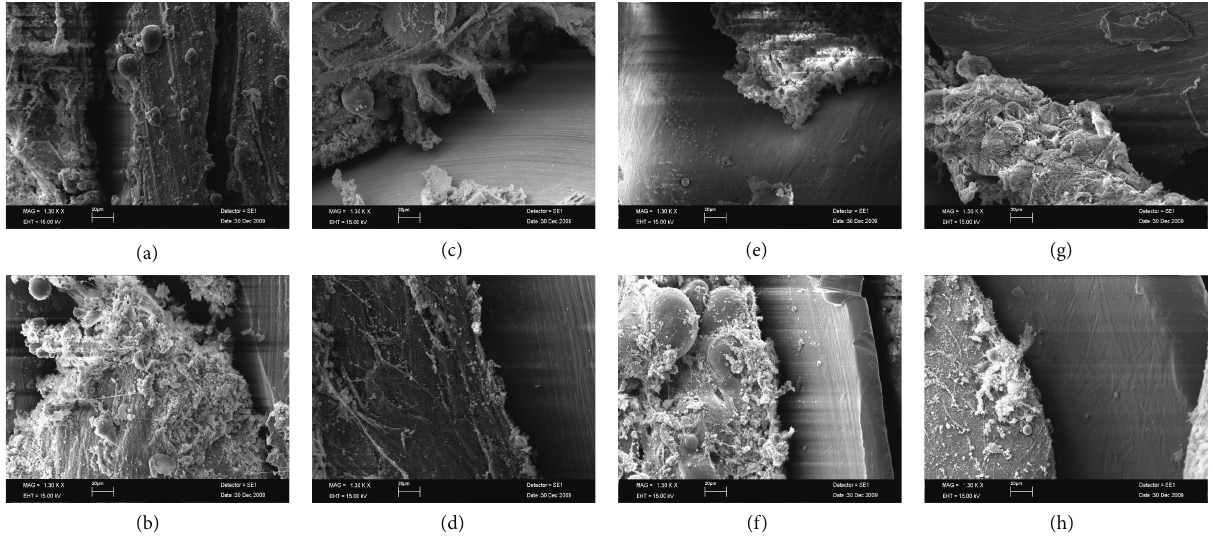
Figure 6: SEM images of loaded ((a) Group I; (c) Group II; (e) Group III; (g) Group IV) and unloaded ((b) Group I C ; (d) Group II C ; (f) Group III C ; (h) Group IV C ) groups, depicting the adaptation between the screw threads and the globular feature of bone-like